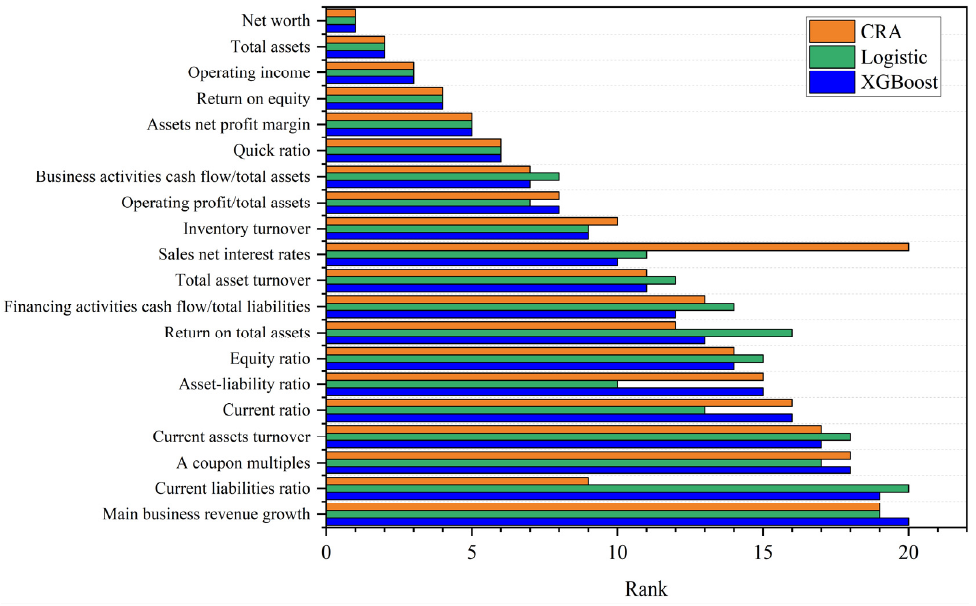
Figure 7. Index ranking comparison of LGFVs.